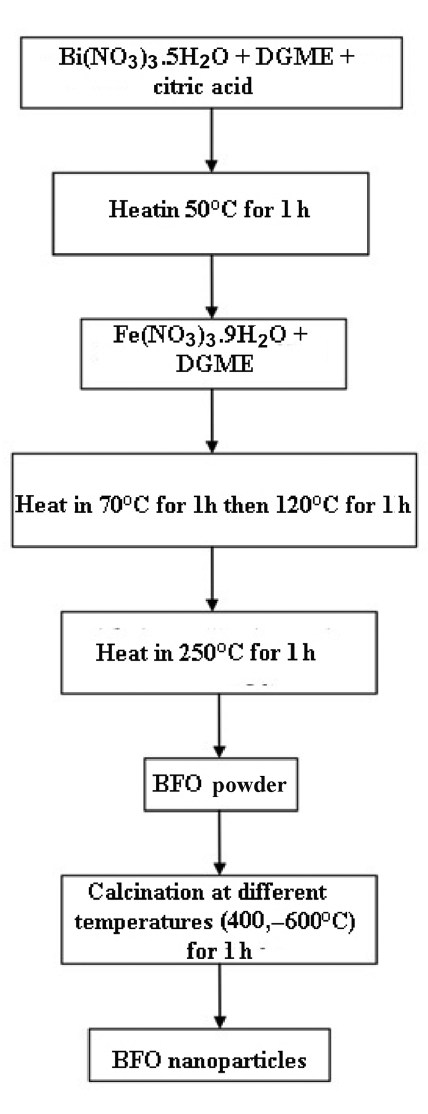
Figure 1: Preparation of BiFeO 3 nanoparticles by Pechini